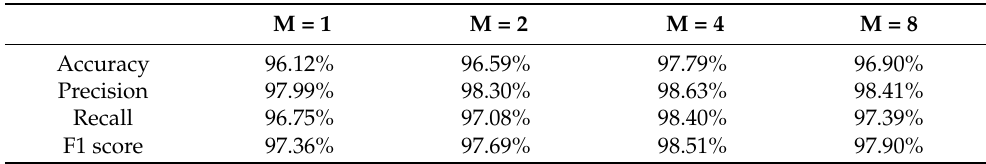
Table 4. Results comparison with different values for multi-head